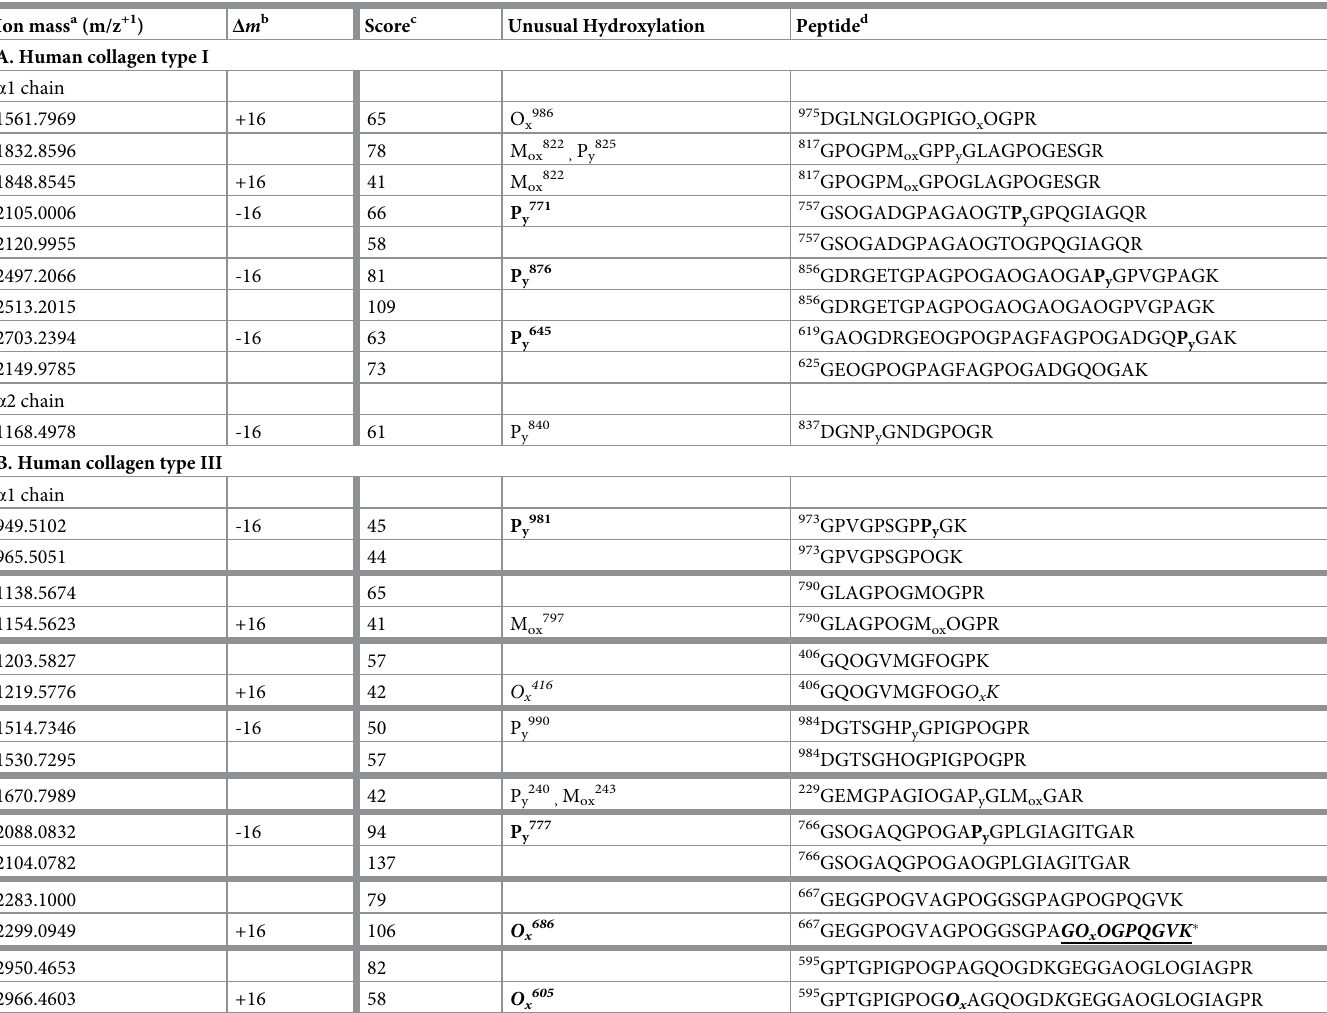
Table 3. Peptides with mass variants of 16 in human